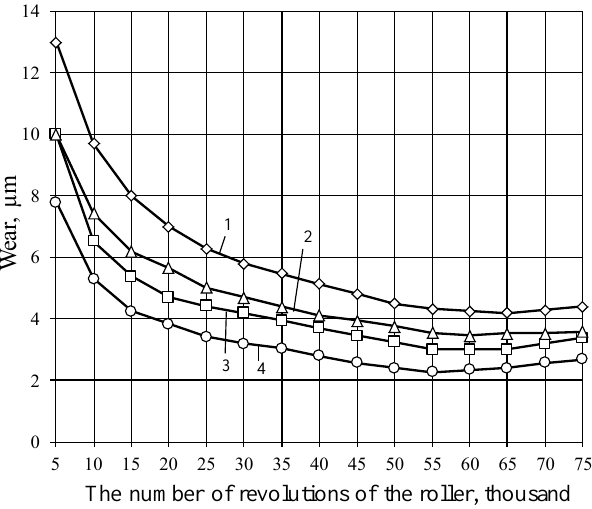
Fig. 7. Dependence of the amount of wear of the "roller-pad" tribocoupling surfaces at the limit friction depending on the duration of the test (Р = 1.5 MPa, V = 0.5 m/s). Tribo-coupling of materials: 1 – "cast iron-PC", 2 – "cast